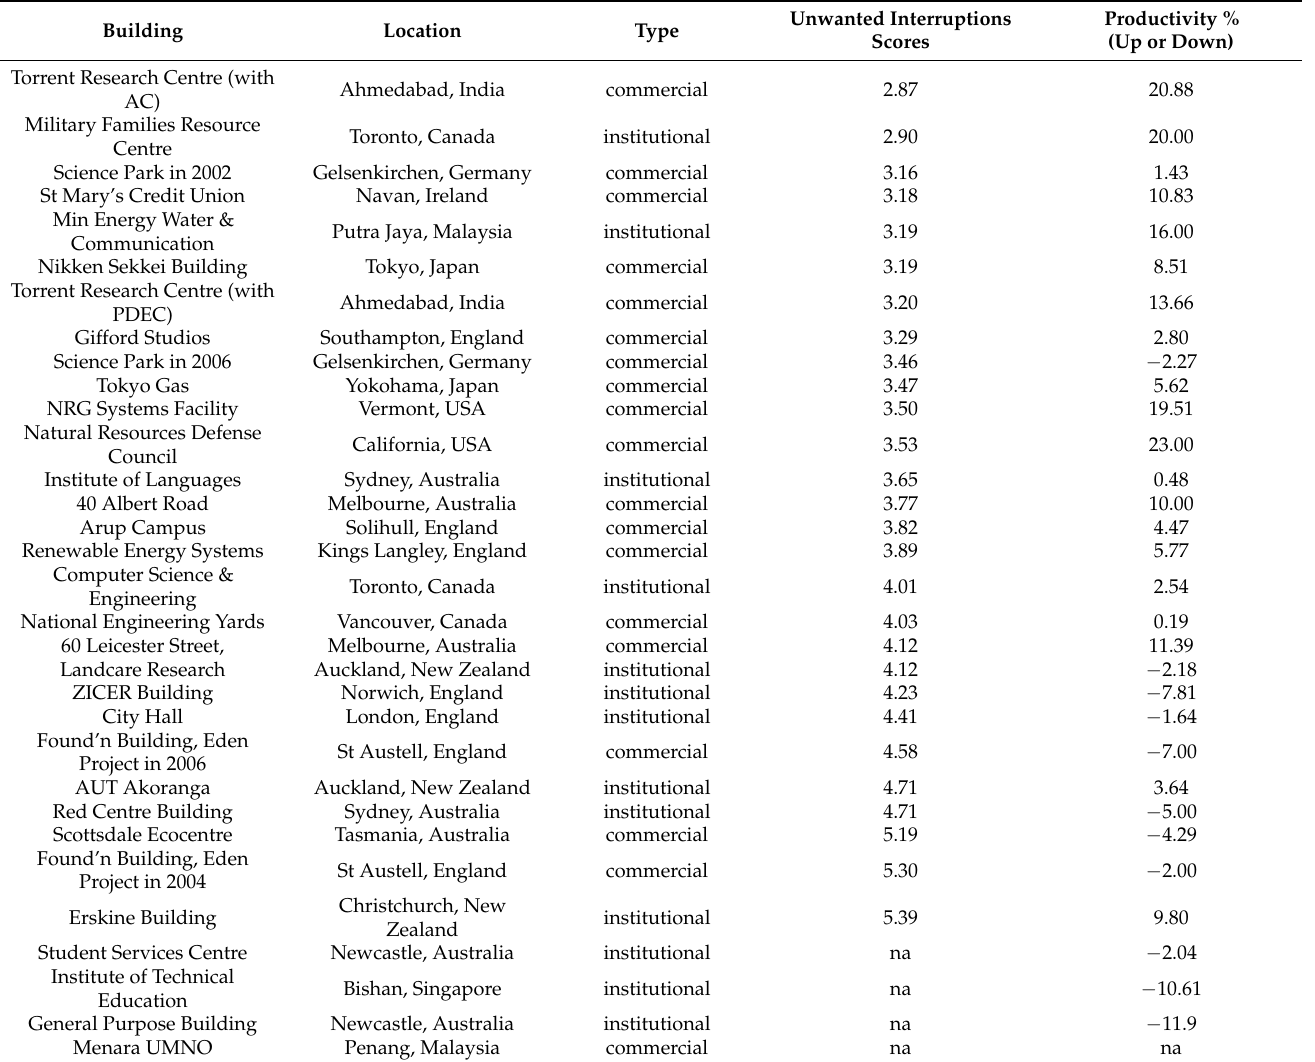
Table 1. List of buildings in “Unwanted Interruptions” order (on a 7-point Scale where 1 is best), together with scores for Perceived